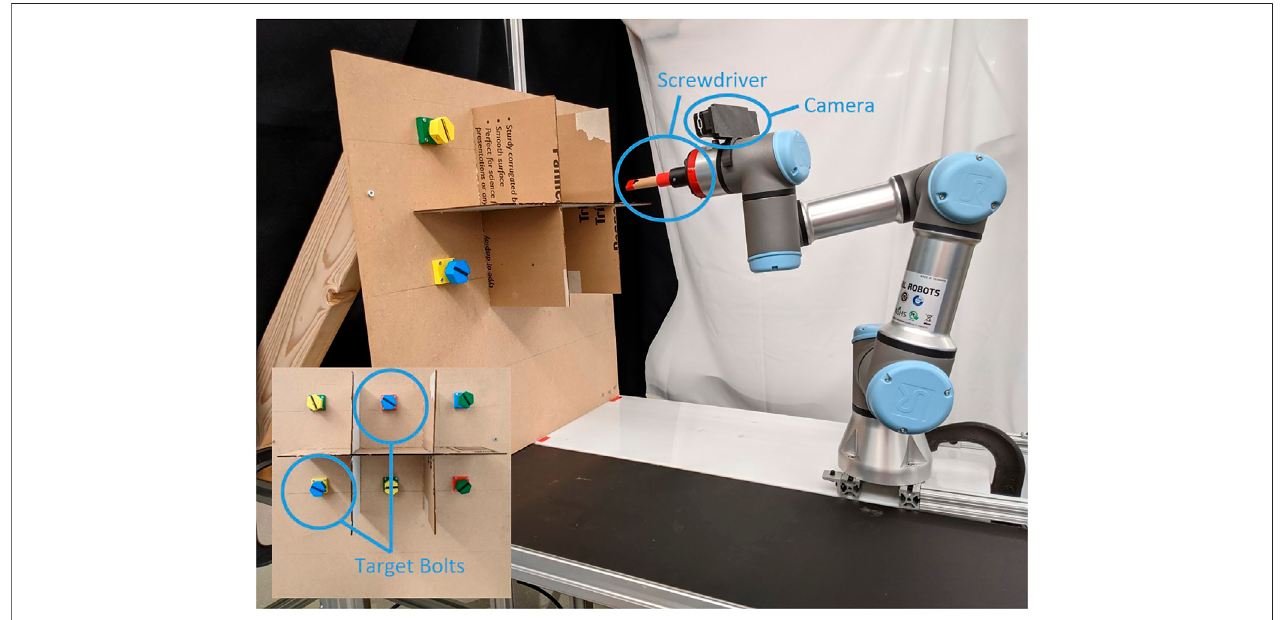
FIGURE 1 | Illustration of the UR3e robotic arm in its initial con fi guration for the screwdriver experiment. In the bottom left is a front-facing view of the blue target bolts that users were requested to tighten in the teleoperation experiment. The robot ’ s end effector has been extended to include a wooden screwdriver, as well as a camera for the precision necessary to complete this